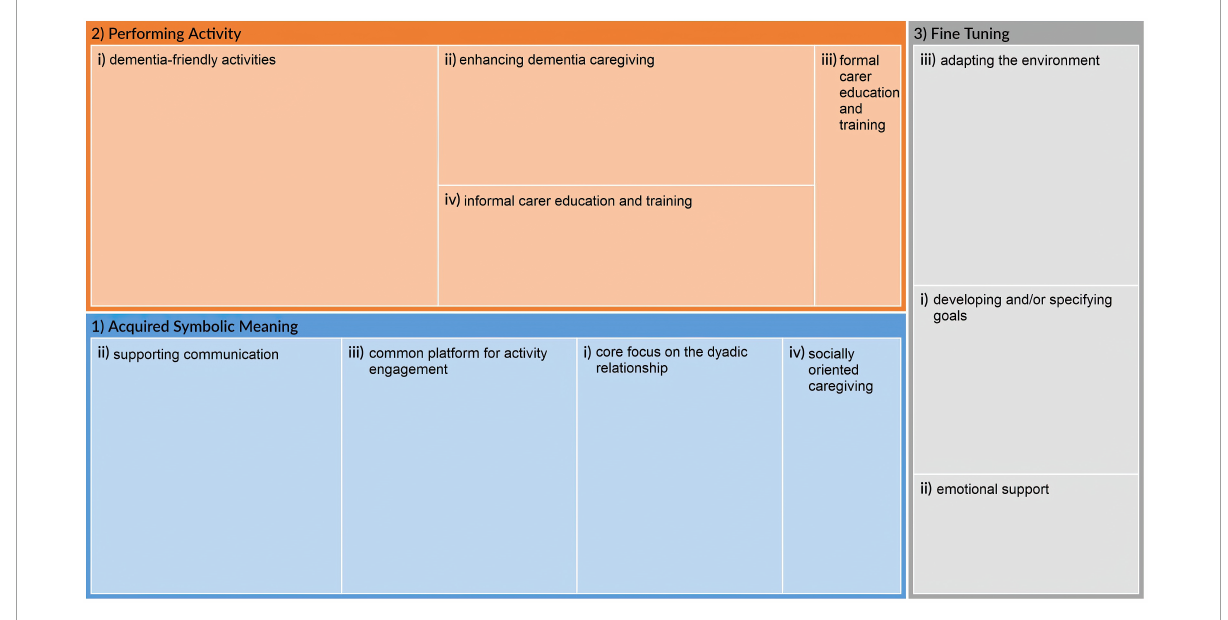
FIGURE2 Treemap of identified categories within each enrichment core